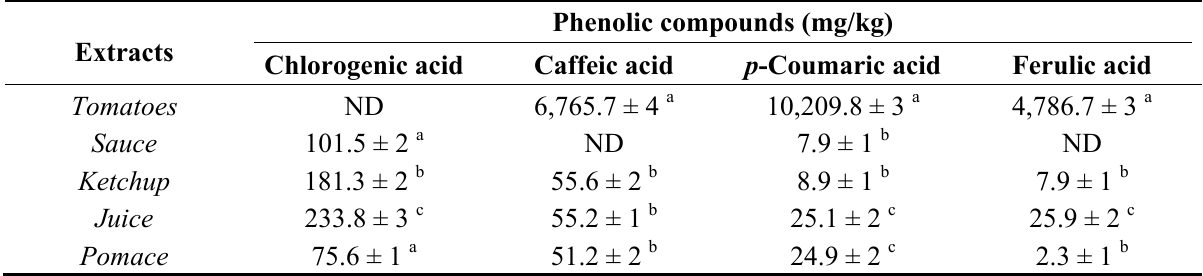
Table 1. Quantification of phenolic compounds in extracts from red tomatoes, tomatoes products (sauce, ketchup and juice) and